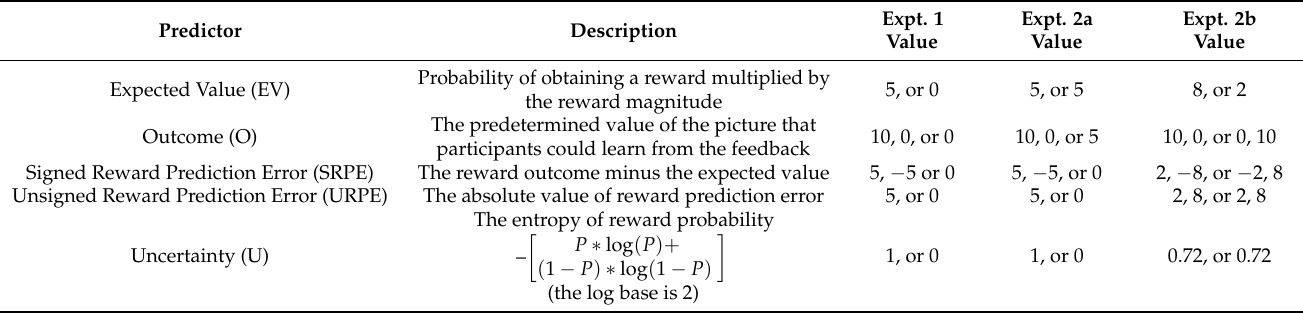
Table 1. Rewarded-related predictors across Experiments 1, 2a, and 2b.